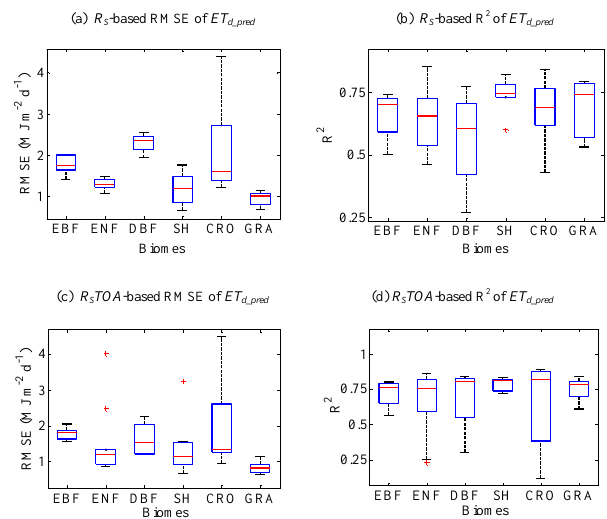
Figure 11. Biome-specific error characteristics of ET d_pred display- ing the box plots of RMSE and coefficient of determination ( R 2 ) from both R S -based and R S TOA-based ET i upscaling. The biome classes are evergreen broadleaf forest (EBF), evergreen needleleaf forest (ENF), deciduous broadleaf forest (DBF), shrubland (SH), cropland (CRO), and grassland (GRA),